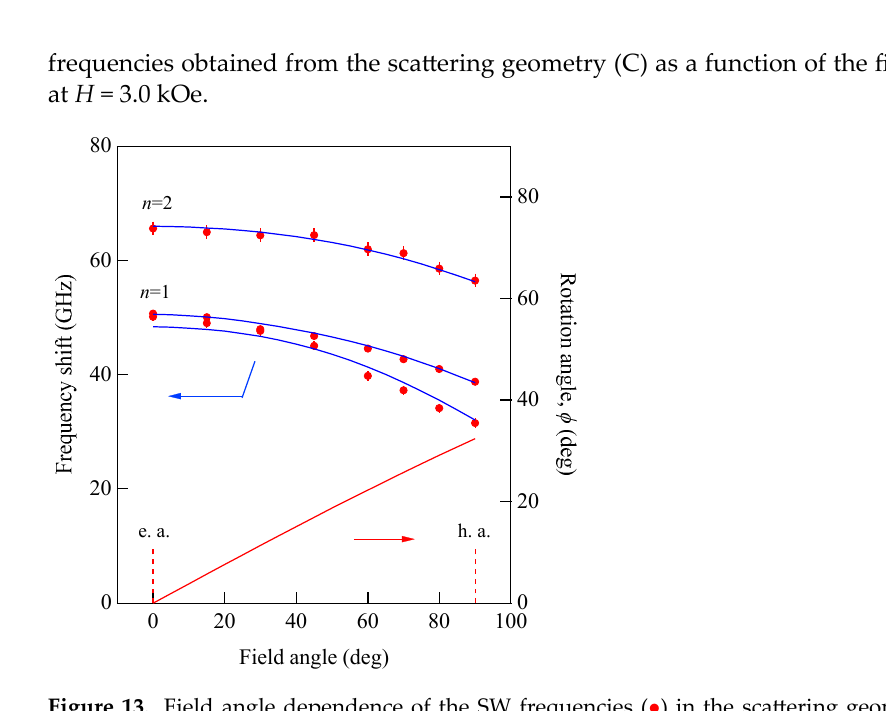
Figure 13. Field angle dependence of the SW frequencies ( • ) in the scattering geometry (C). The solid lines were calculated for the SW frequencies ( − ) and the rotation angle ϕ of the magnetization ( − ) using the full magnetic constants given in the text [74]. Here, e.a. and h.a. mean the easy axis ( y C -direction) and the hard axis ( z C -direction) in Figure 10.